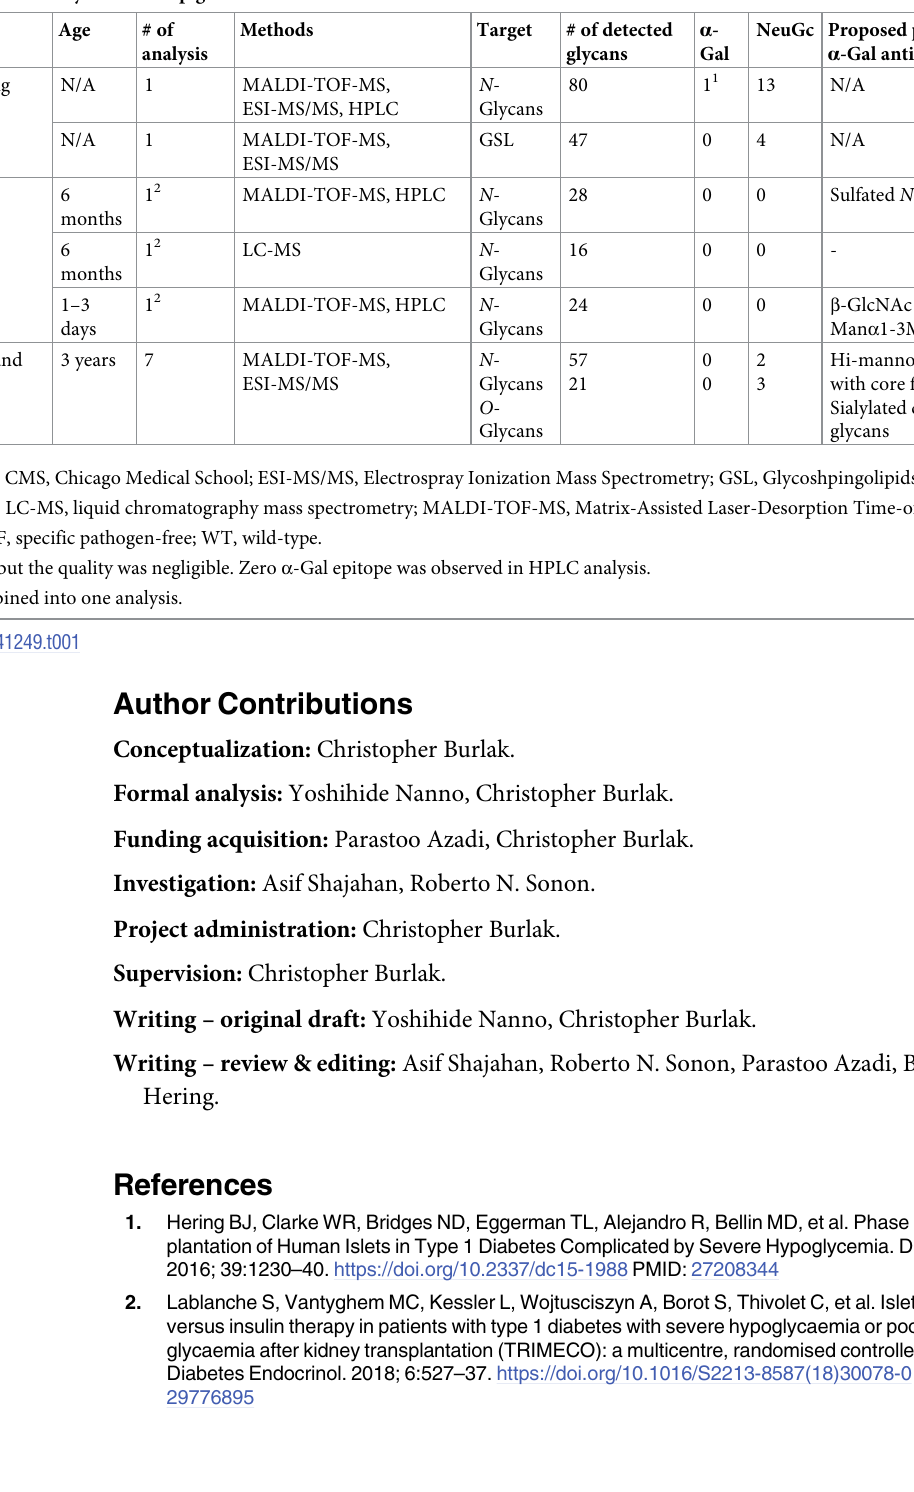
Table 1. Characteristics of mass spectrometry studies for pig